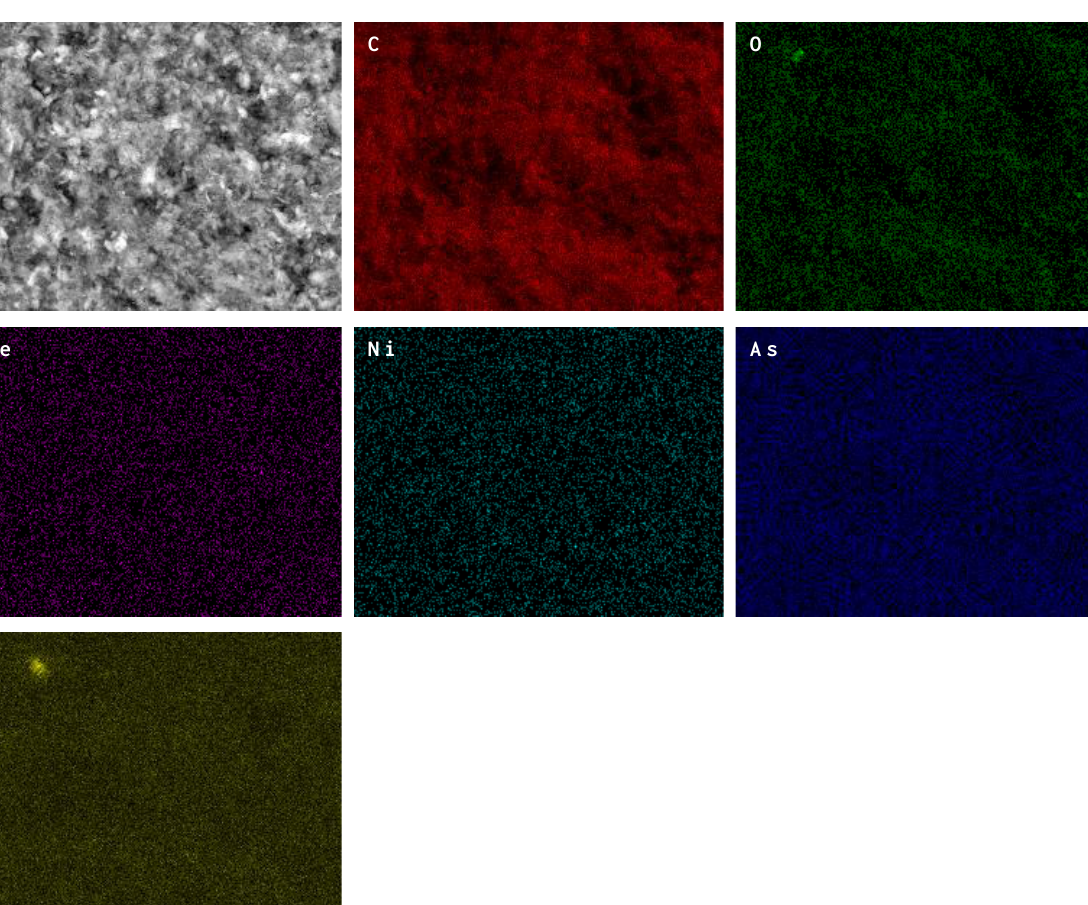
× 2500 2 Ni 2 @MWCNT_N6 at